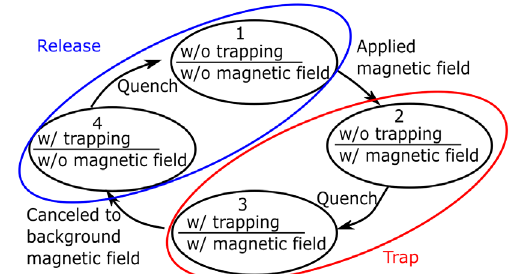
FIG. 5. The sequence of the flux trapping experiment: 1. State demonstrates that the cavity did not trap magnetic flux, and the environment magnetic field was canceled. 2. State demonstrates that the cavity did not trap magnetic flux, and the environment magnetic field was applied. 3. State demonstrates that the cavity trapped magnetic flux, and the environment magnetic field was applied. 4. State demonstrates that the cavity trapped magnetic flux, and the environment magnetic field was canceled. The cavity state can therefore be changed by quenches, and the environment magnetic field was controlled by the solenoid coil current. The arrows show the manipulated coil or quench event between each